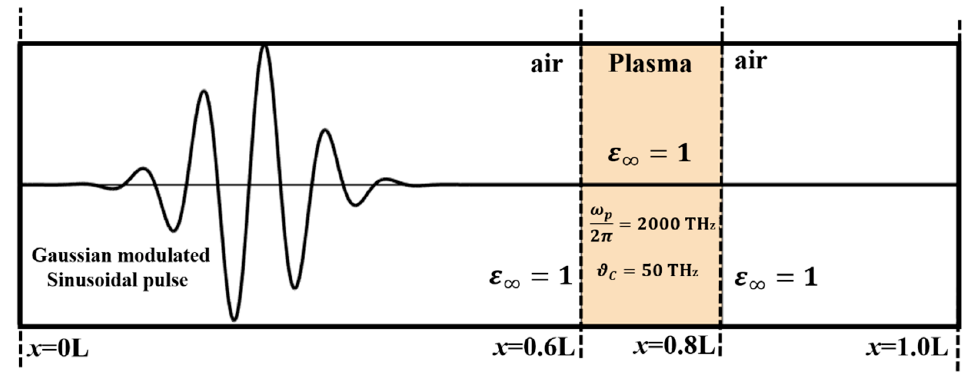
Figure 4. Schematic computational domain and incident Gaussian-modulated sinusoidal pulse through a film of the dispersive medium.